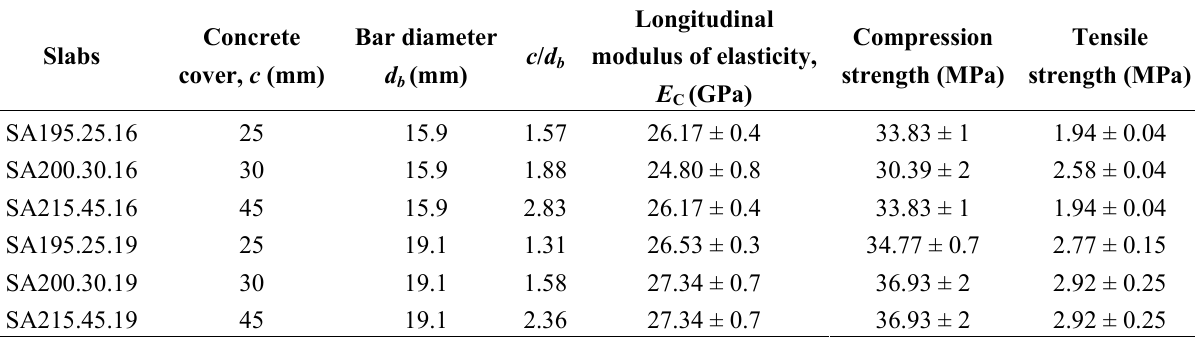
Table 1. Mechanical properties of concrete